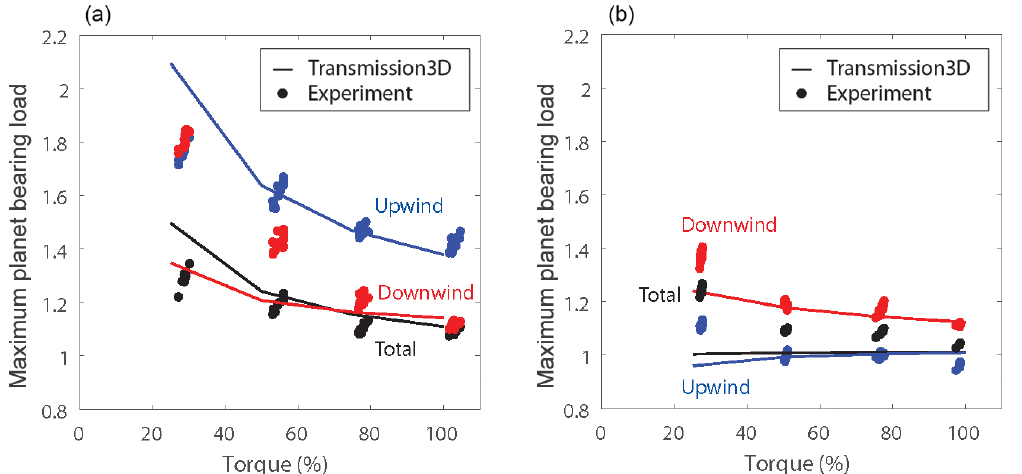
Figure 13. Maximum planet CRB (a) and TRB (b) loads for all